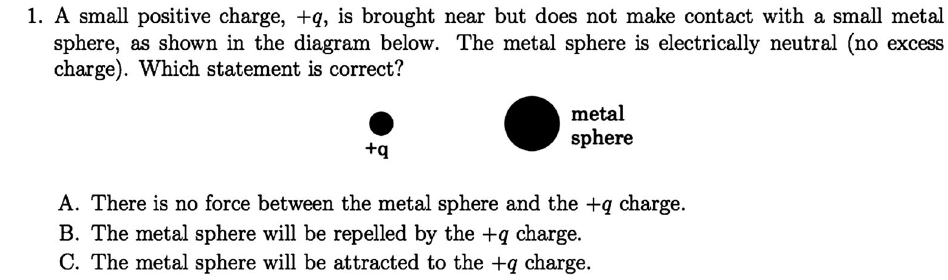
FIG. 1. Question 1, an example of one of the most difficult questions, from the EMCA assessment.